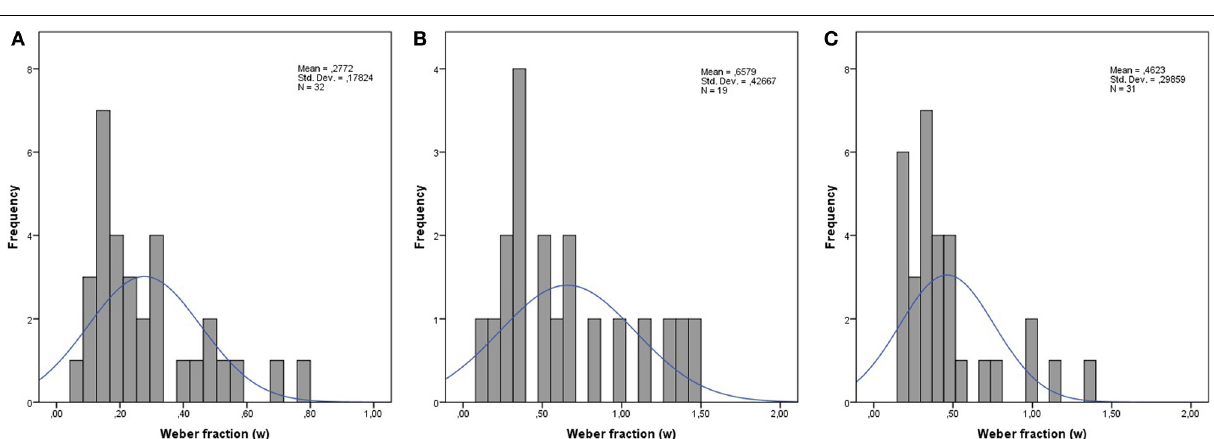
FIGURE 1 | Histogram of internal Weber fractions on the number discrimination task for (A) TA4, (B) DD, and (C) TA2.